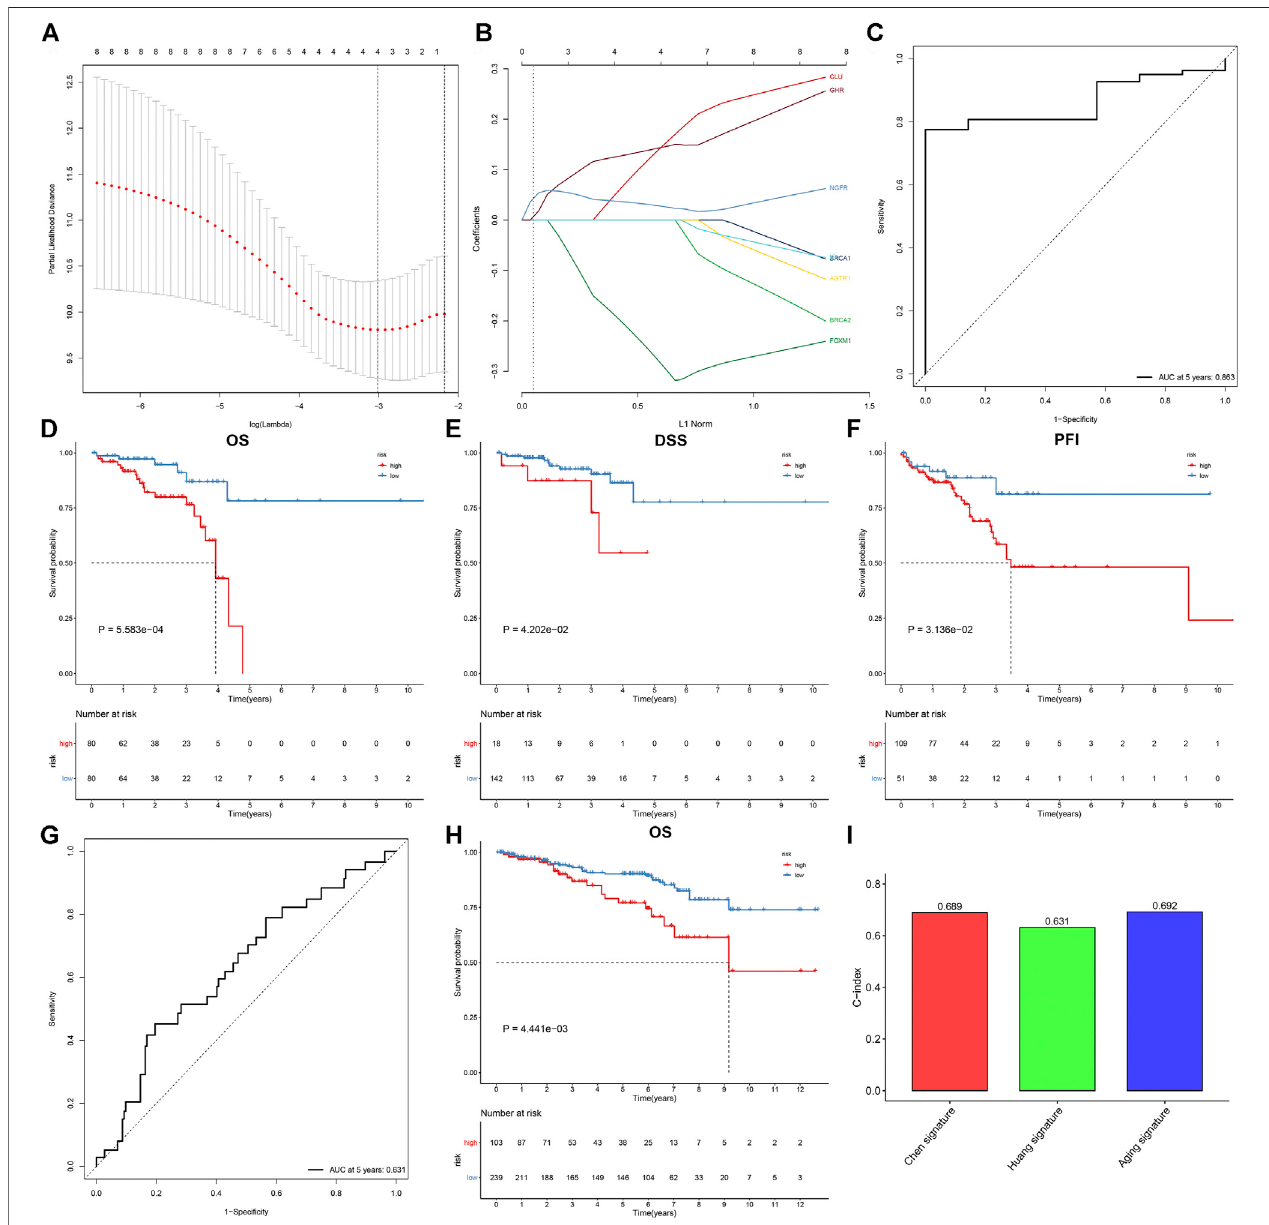
FIGURE 2 | Establishment and external veri fi cation of an aging-related gene model for rectal cancer prognosis. (A) Partial likelihood deviance corresponding to different lambda values. (B) LASSO coef fi cient pro fi les. (C) ROC curves at 5-year survival in the discovery set. (D – F) Kaplan – Meier curves of OS, DSS, and PFI in high- and low-risk patients in the discovery set. (G, H) ROC curves at 5-year survival as well as OS analysis for rectal cancer patients in the testing set. (I) Comparison of the C-index among the aging-related gene model and existing gene models (Chen et al. signature and Huang et al. signature).